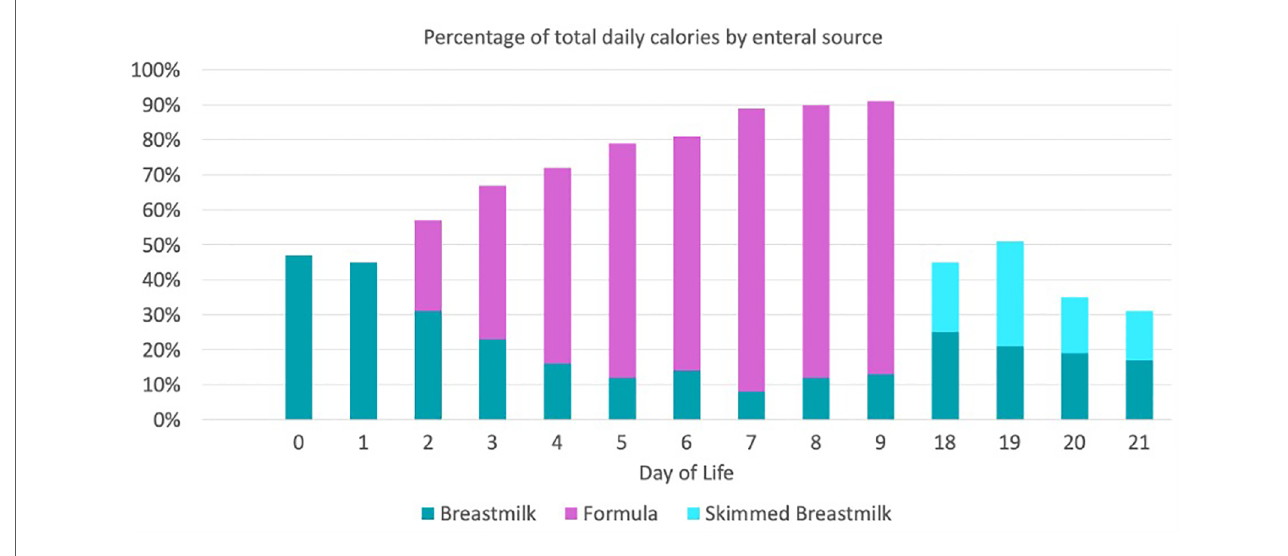
FIGURE 2 Enteral feeding advancement regimen prior to developing NEC. *SolCarb was added starting on day of life 5. *Similac liquid protein forti fi er was added starting on day of life